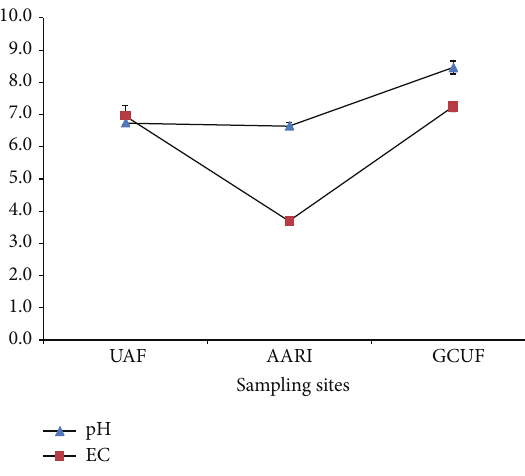
Figure 2: Chemical properties of soil collected from root zone of plants growing in semiarid zone. UAF: University of Agriculture, Faisalabad; AARI: Ayub Agricultural Research Institute, Faisalabad; GCUF: Government College University, Faisalabad; EC: electrical conductivity (dSm −1